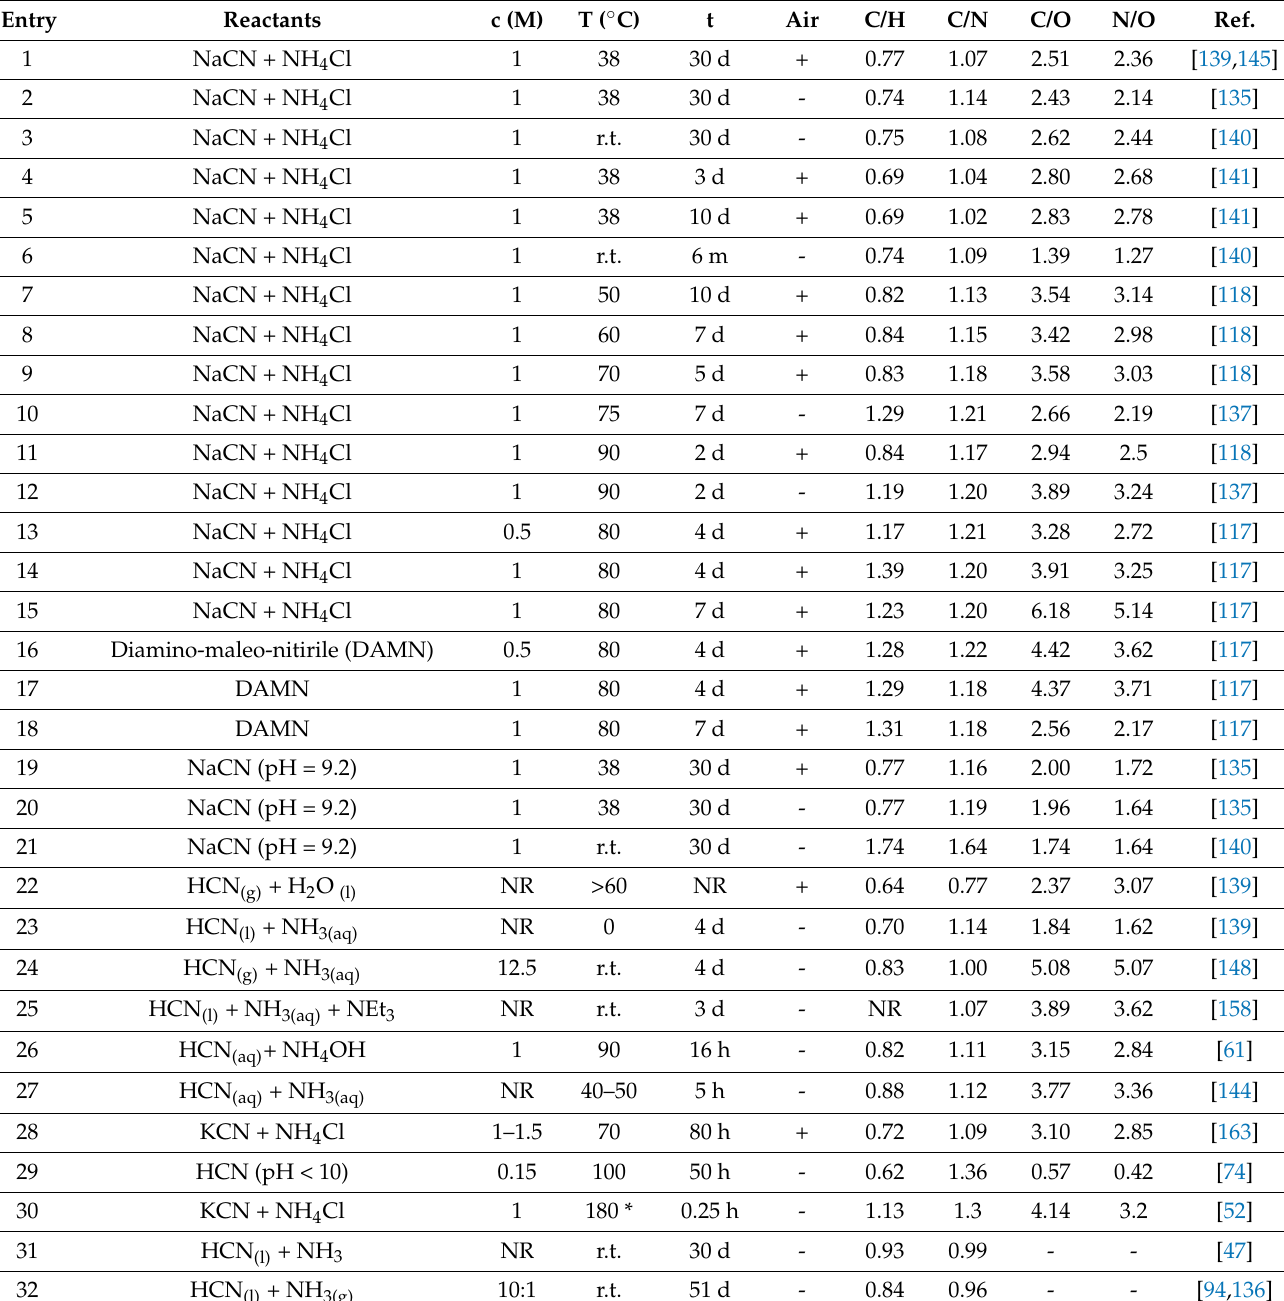
Table 1. Molar relationships found for representative insoluble HCN-derived polymers synthesized under aqueous conditions (with the exception of entries 31 and 32) and using different experimental temperature, concentration, reaction time and initial pH parameters. The presence of air (+) is also considered due to its influence on the HCN polymerization processes. r.t. = room temperature; d = days; h = hours; m = months. * polymerization driven by microwave